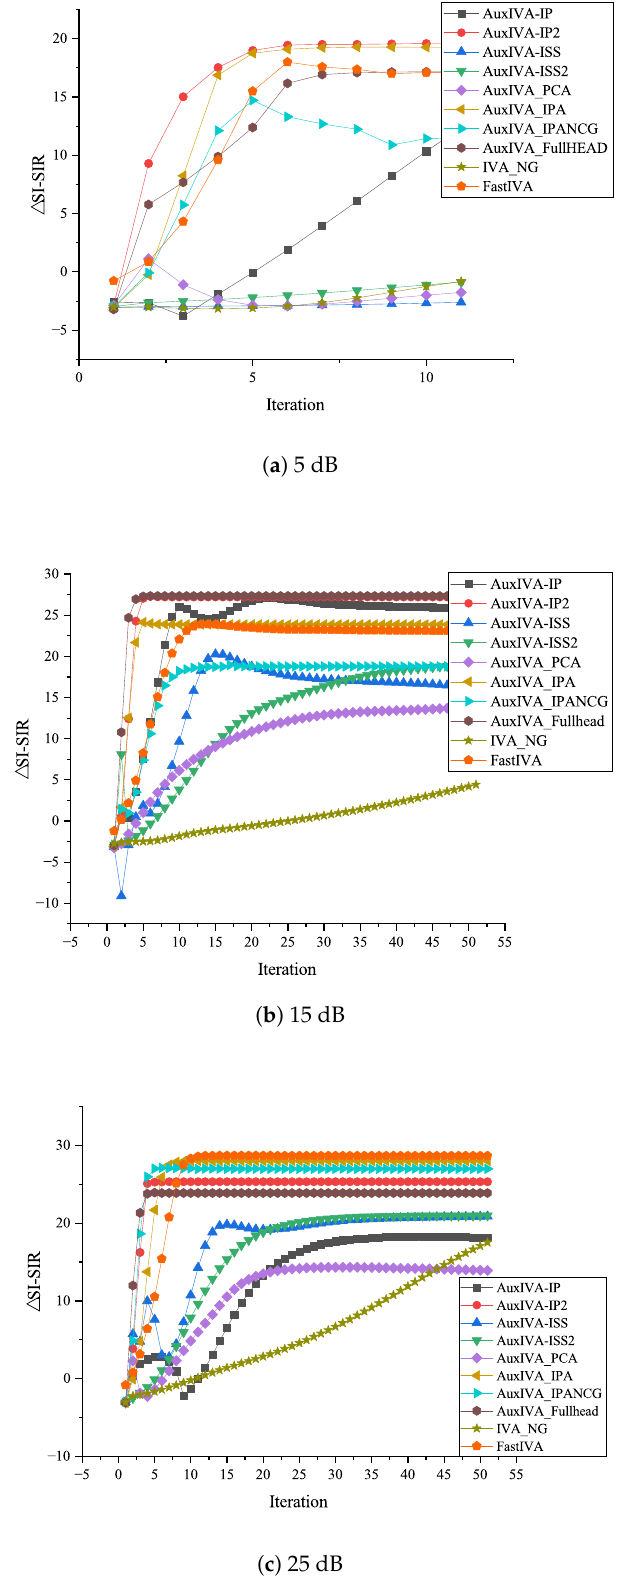
Figure 11. Performance comparison under different SNRs in the 3 × 3 determined